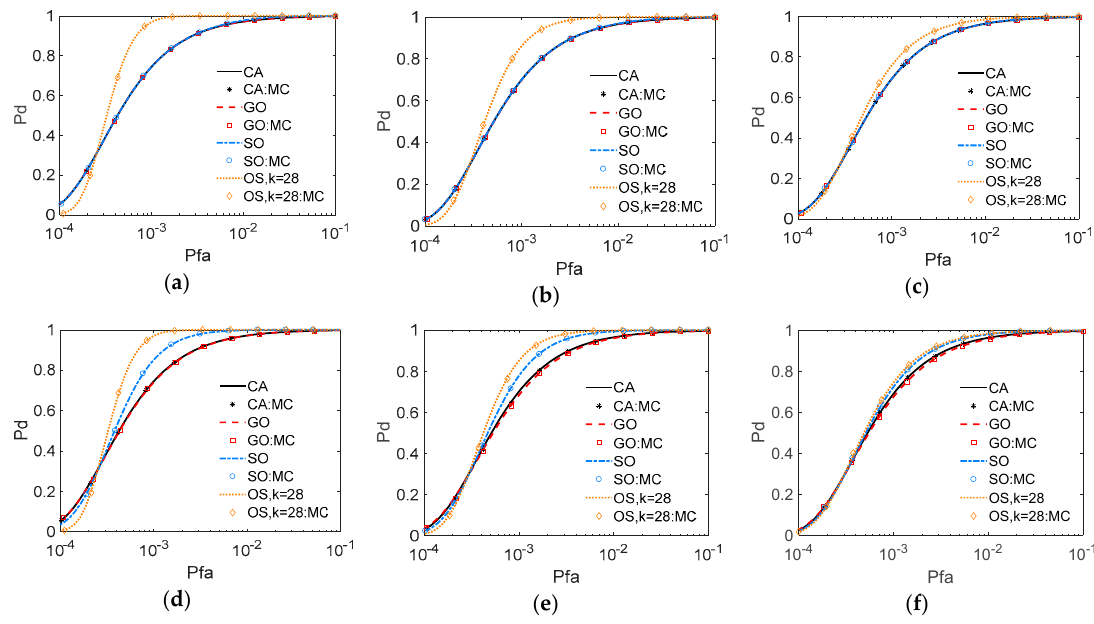
Figure 8. The receiver operating characteristic (ROC) curves of the different detectors in a nonhomogeneous P α S background. The parameters are N = 32, γ = 1 and µ = 100. ( a ) α = 0.2, R = 8 and GSCR = 35 dB ; ( b ) α = 0.5, R = 8 and GSCR = 13 dB ; ( c ) α = 0.8, R = 8 and GSCR = 7 dB ; ( d ) α = 0.2, R = 24 and GSCR = 55 dB ; ( e ) α = 0.5, R = 24 and GSCR = 21 dB ; ( f ) α = 0.8, R = 24 and GSCR = 12 dB .